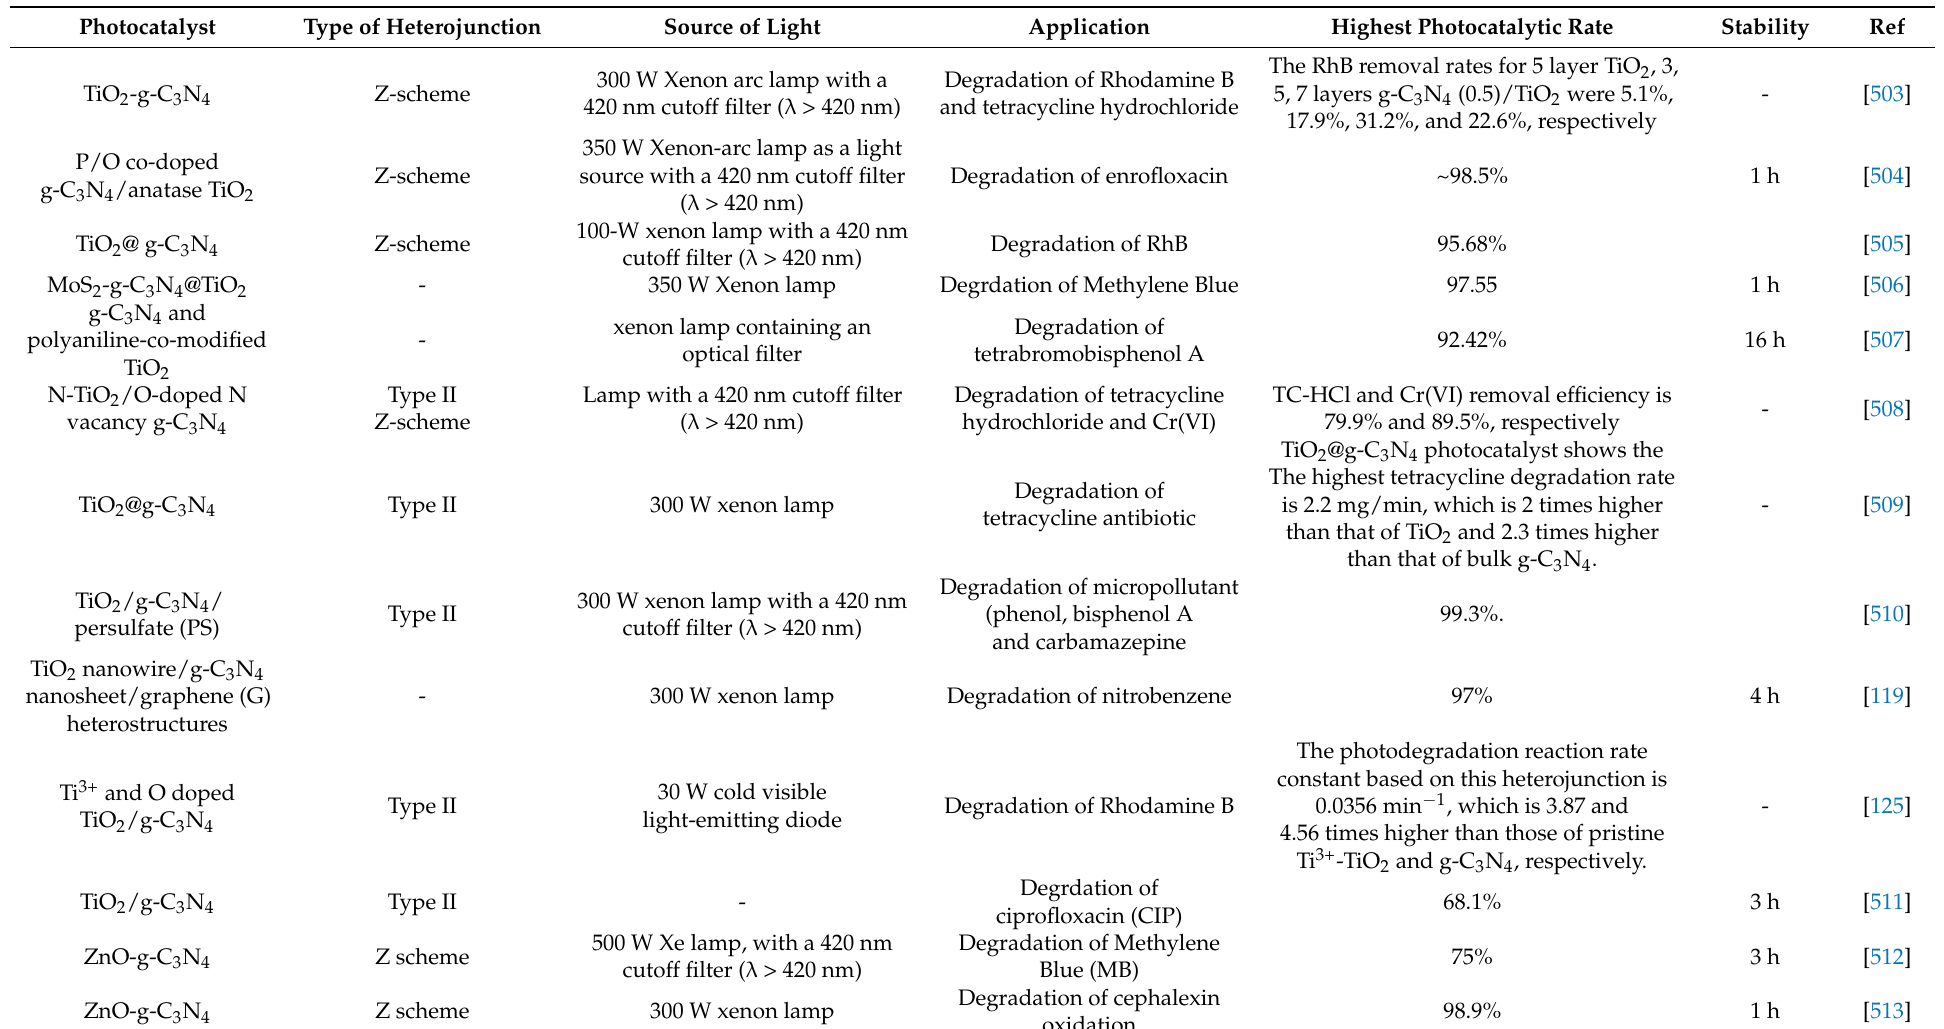
Table 4. the photodegradation application of g-C 3 N 4 –metal oxide-based